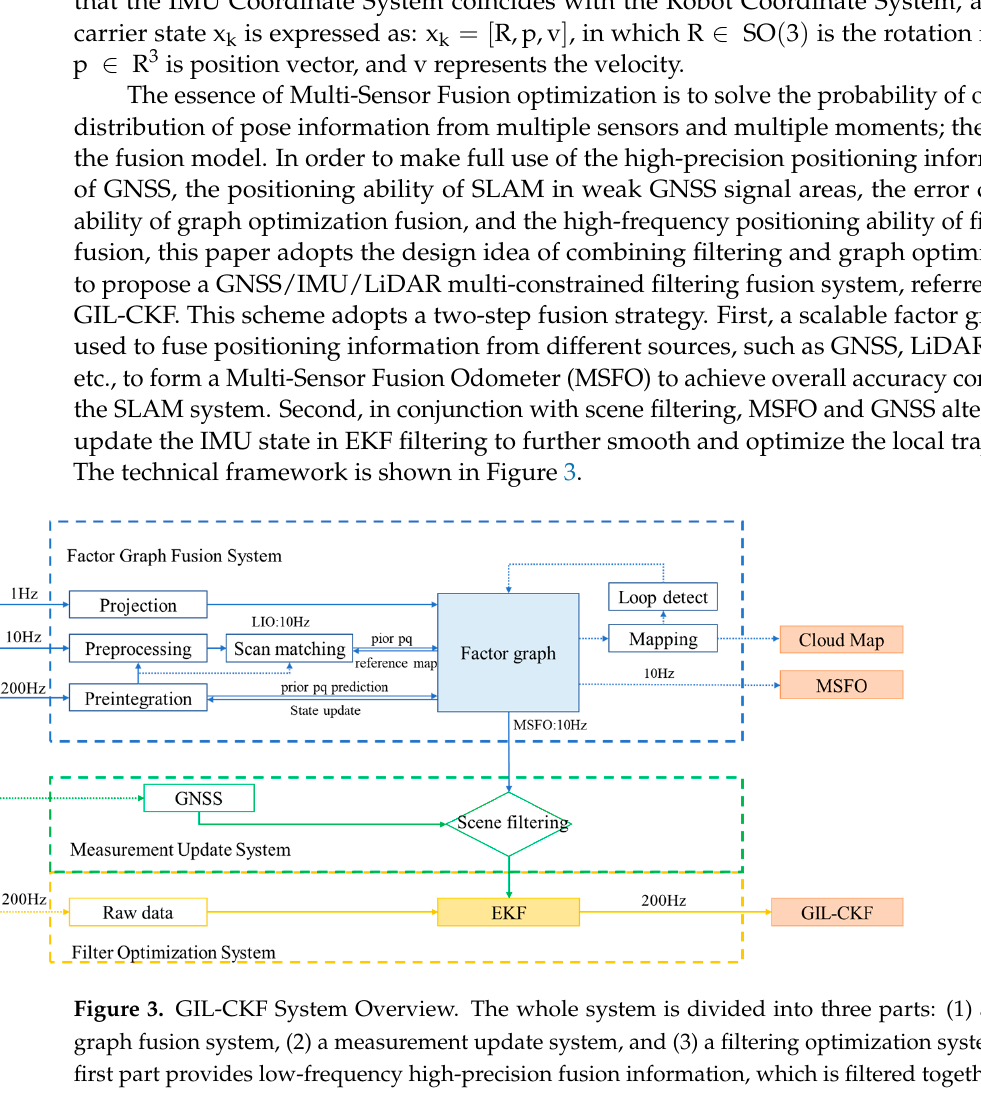
Figure 2. Unmanned vehicle hardware platform.